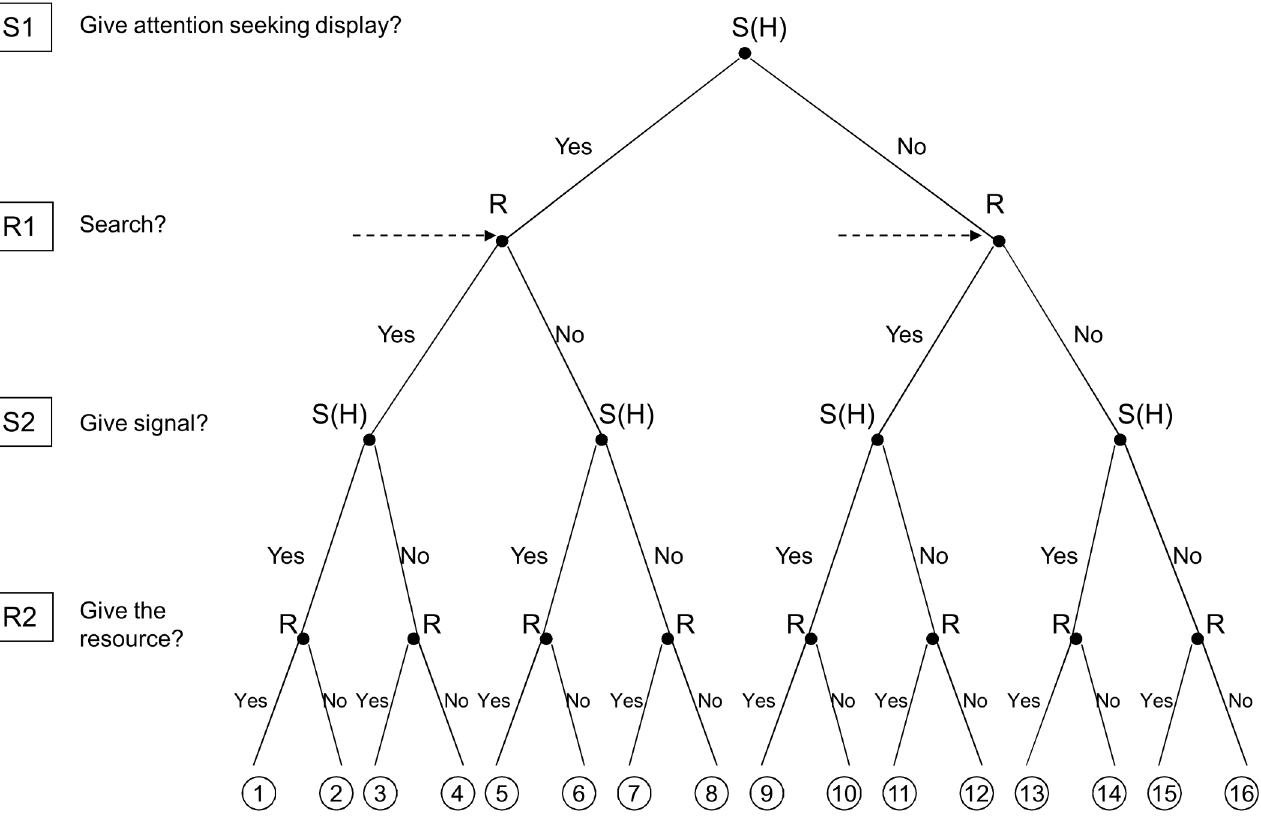
Fig 1. Extensive form of the signalling game. S1, S2 and R1, R2 denote the decisions the signaller and the receiver have to make respectively; S1: ASD stage, give or not to give an ASD; R1: search stage: search or not to search for ASDs; S2: quality signalling stage: give or not to give a quality signal; R2: decision stage: give or not to give the resource to the signaller. R and S(H) denote receiver and high quality signaller respectively. For the sake of simplicity the tree does not show the decision made by nature, i.e. the step that specifies the quality of signaller, it only shows the game for high quality signallers. The same decision tree can be drawn for low quality signallers. Dotted arrows denote the nodes where the receiver cannot tell whether the node is part of the first or the second tree, i.e. where the receiver cannot tell whether the signal (or lack of it) comes from a high or a from a low quality signaller. Table 2 gives the fitness values corresponding to the end